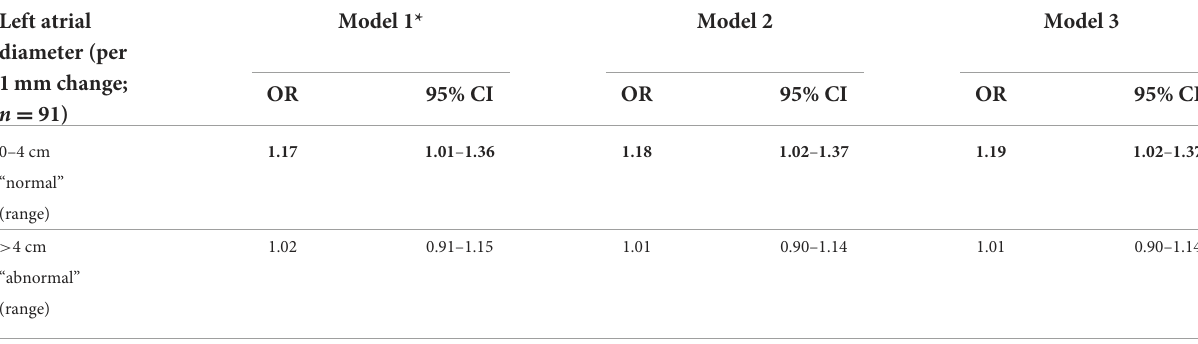
TABLE 2 Logistic regression analysis demonstrating the odds of scoring in the high SIS category per unit change within the specified LAD range, among ischemic stroke survivors without AF. Left atrial